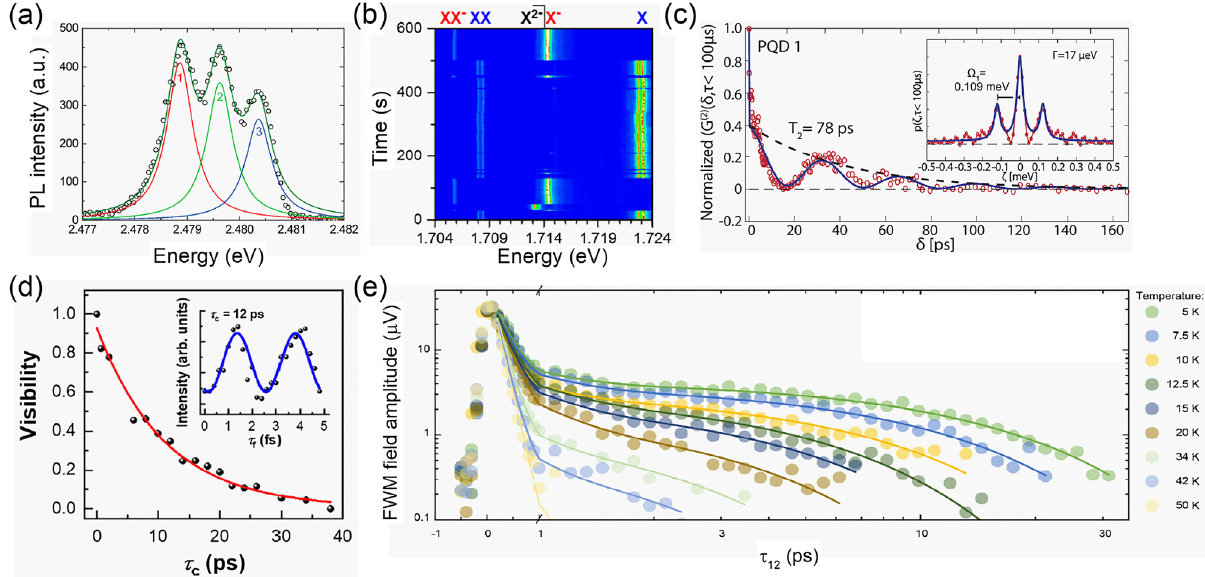
Figure 14: (a) PL spectrum measured from a single CsPb(Cl/Br) 3 nanocrystal with three emission peaks. Reproduced with permission [182]. Copyright 2016, American Chemical Society. (b) Time-dependent PL spectra from a single CsPbI 3 nanocrystal excited at N = ∼ 1.5 with different emission species marked on the top by XX − , XX, X 2 − , X − and X, respectively. Reproduced with permission [183]. Copyright 2017, American Physical Society. (c) For a single CsPbBr 3 nanocrystal with Ω 1 = 0.109 meV, the dephasing time of exciton fi ne structure of T 2 = 78 ps can be fi tted from the photon-correlation Fourier spectroscopy data, corresponding to a PL linewidth of Г = 17 μ eV estimated from the Fourier- transformed spectral correlation (inset). Reproduced with permission [184]. Copyright 2019, American Association for the Advancement of Science. (d) Quantum interference measurement of a single CsPbI 3 nanocrystal. Inset exhibited the PL intensity measured at τ c = 12 ps as a function of τ f showing an oscillating behavior due to quantum interference between the wavefunctions of two excitons. Reproduced with permission[185].Copyright2019,AmericanChemicalSociety.(e)Four-wavemixing fi eldamplitudeas afunctionofthetimedelay τ 12 between the fi rst and the second pulse in the temperature 5 – 50 K for fi xed τ 23 = 1 ps. Inset: Schematic of the three-beam pulse sequence and the resulting photon echo. Reproduced with permission [186]. Copyright 2018, American Chemical